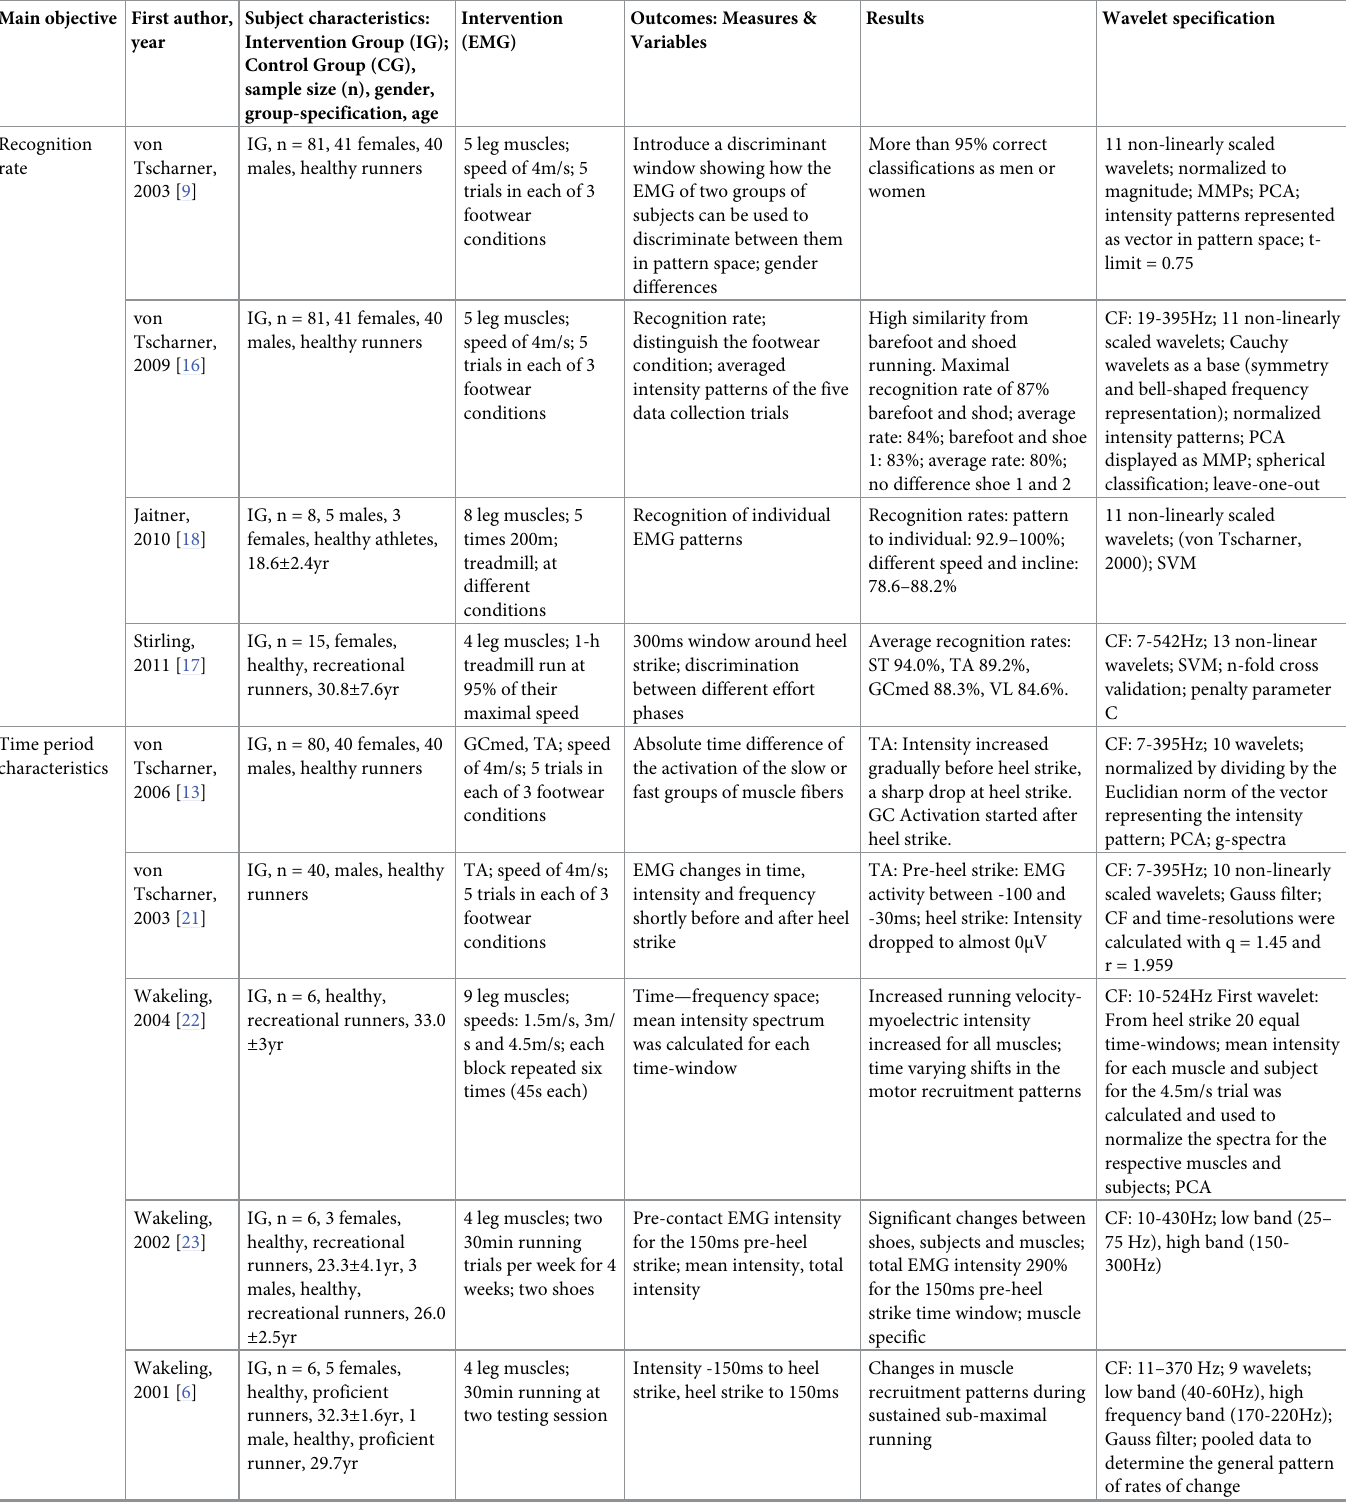
Table 3. Data extraction: Summary of wavelet analysis of EMG of lower extremity muscles while running and different conditions. Main objective First author,